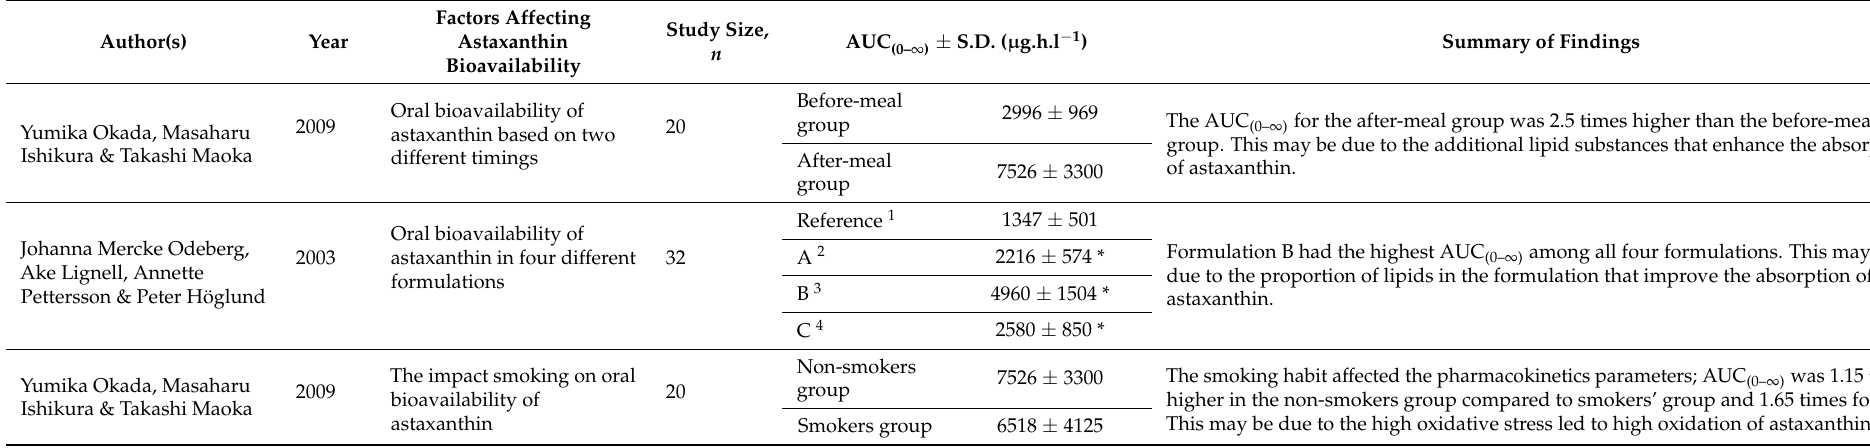
Table 1. Pharmacokinetic parameters of